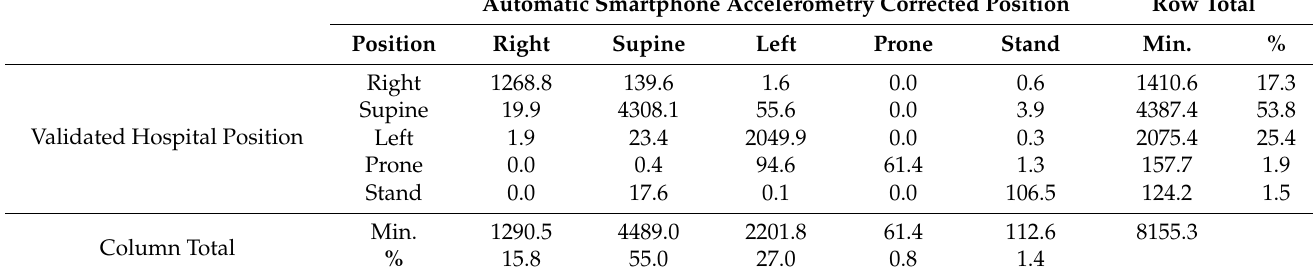
Table 3. Confusion matrix in minutes of the comparison between automatic smartphone corrected position and validated PSG position. Automatic Smartphone Accelerometry Corrected Position Row Total Position Right Supine Left Prone Stand Min. %